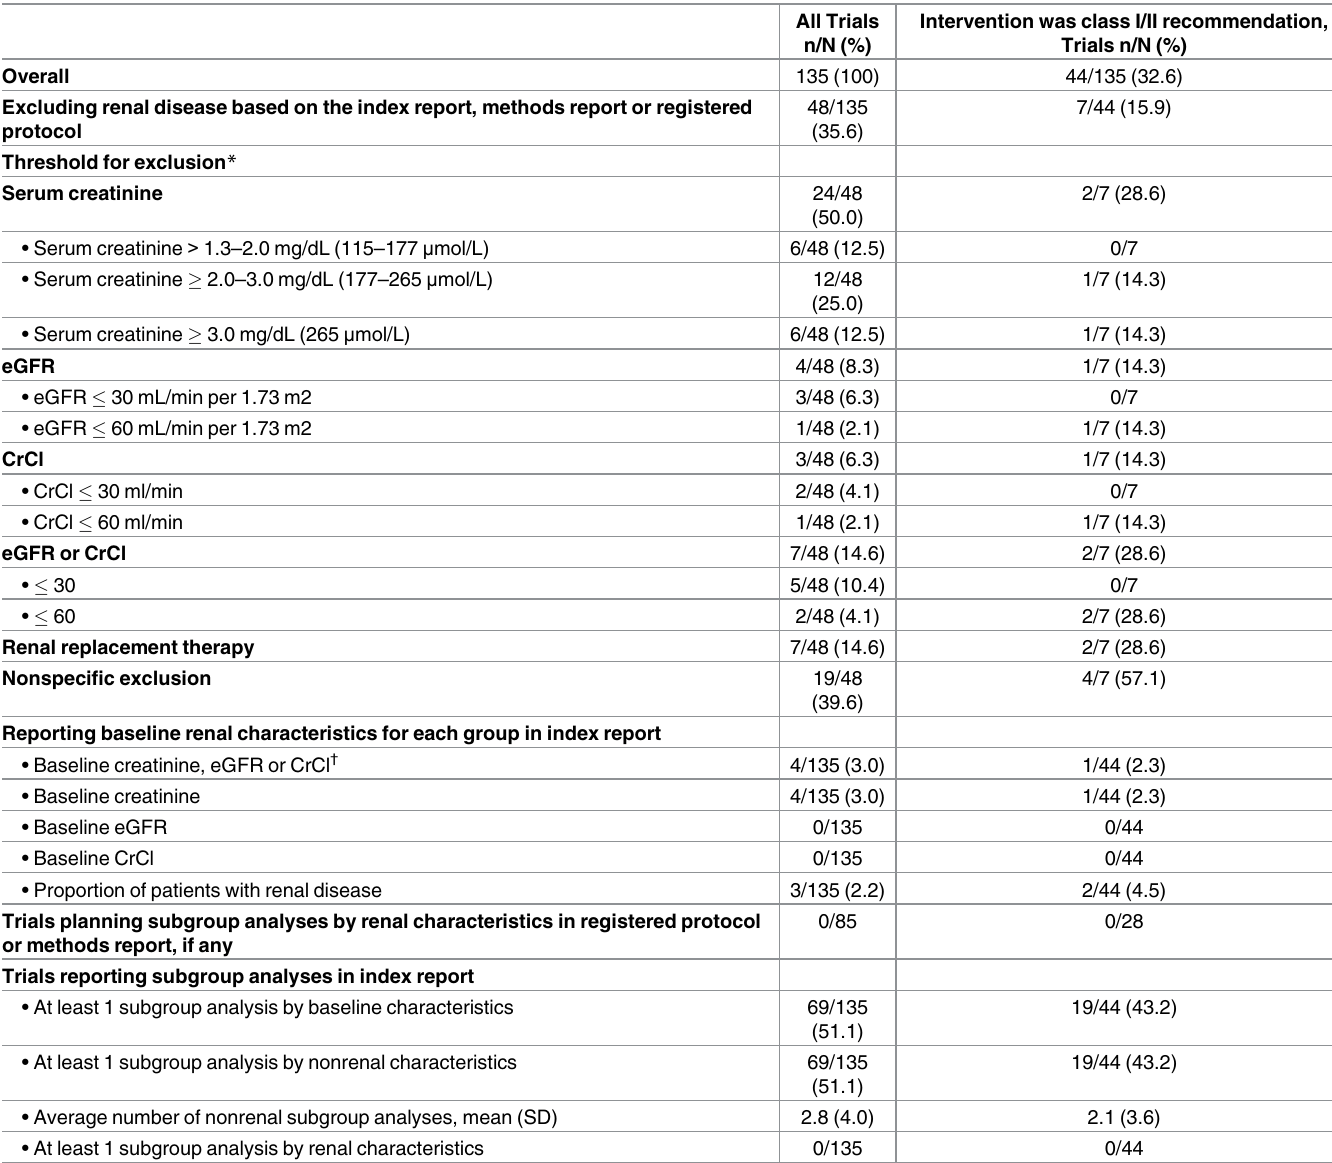
Table 2. Exclusion of kidney disease and reporting of renal function in cerebrovascular